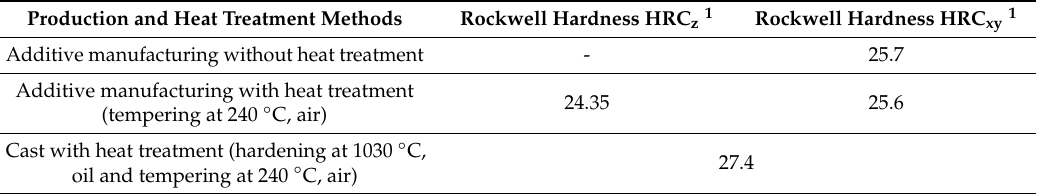
Table 7. Hardness without and with heat treatment of 12Kh18N9T (DIN 1.4541) steel samples.